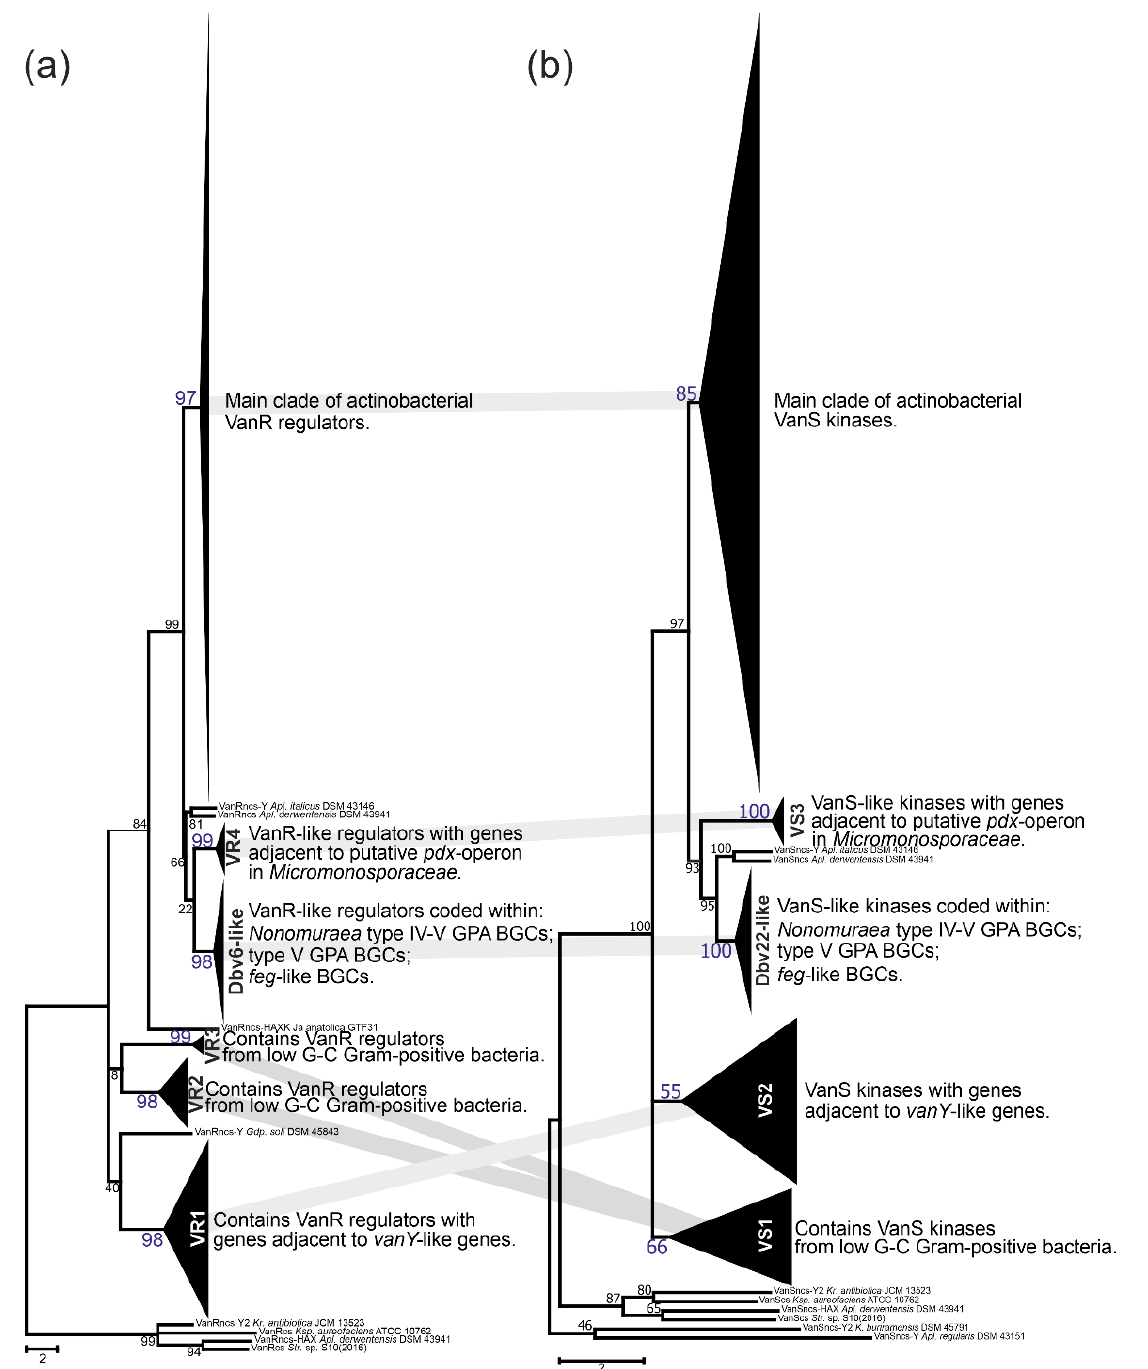
Figure 11. Phylogenetic trees of actinobacterial VanR-like response regulators ( a ) and VanS-sensor histidine kinases ( b ). Defined clusters on each tree were collapsed; for the expanded versions, please refer to ESM Figures S16–31. Coherent clusters are joined with thick grey lines. Please see main text for more details. Scale bar represents the number of substitutions per site.